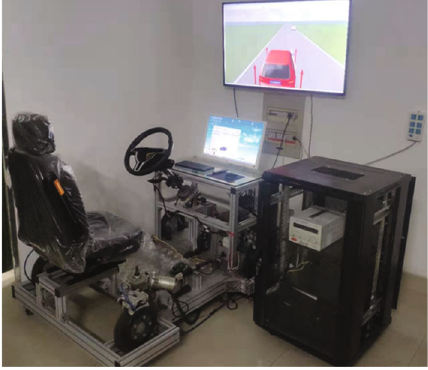
Figure 6: Hardware-in-the-loop test